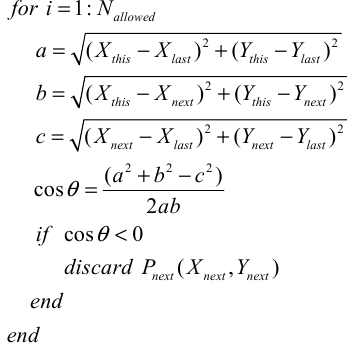
Figure 6. Pseudocode for intersection angle constraints.